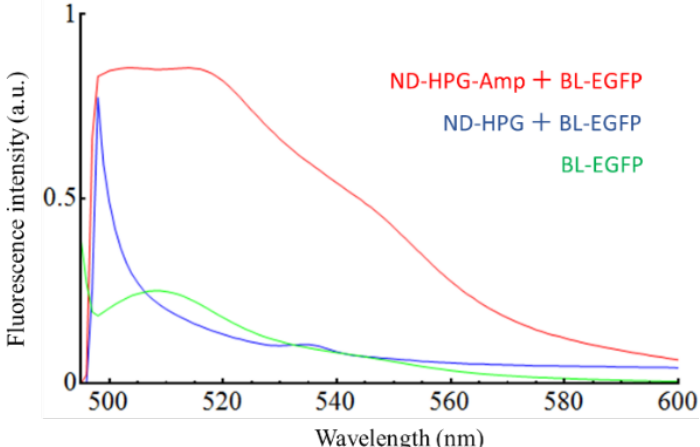
Figure 2. Fluorescence emission spectra of BL-tagged enhanced green fluorescent protein (BL-EGFP) (green), FND-HPG-Amp (red), and FND-HPG (blue) in Tris-HCl buffer after 2 h incubation with BL-EGFP and subsequent washing. Excitation wavelength was 488 nm. FND-HPG-Amp: fluorescent nanodiamond-hyperbranched polyglycerol-ampicillin; FND-HPG: fluorescent nanodiamond-hyperbranched polyglycerol; a.u.: arbitrary unit.